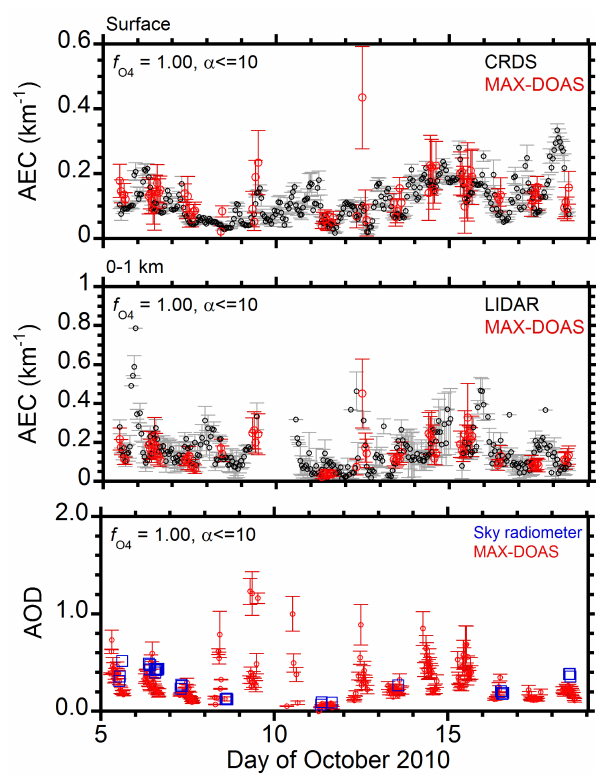
Figure 13. Same as Fig. 4, but a f O DOAS retrieval. α used in the retrieval was limited to ≤ 10 ◦